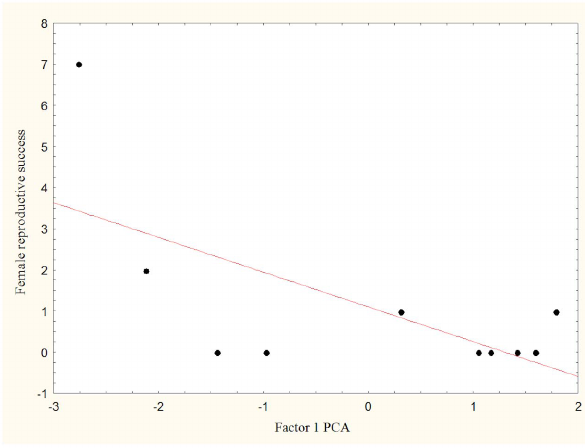
Figure 5. The relation between ‘female reproductive success’ and the first factor of the PCA developed for females. Reproductive success has been assessed as number of puppies survived to maturity. High negative values on factor 1 indicate high-ranking and old females who often led the pack.